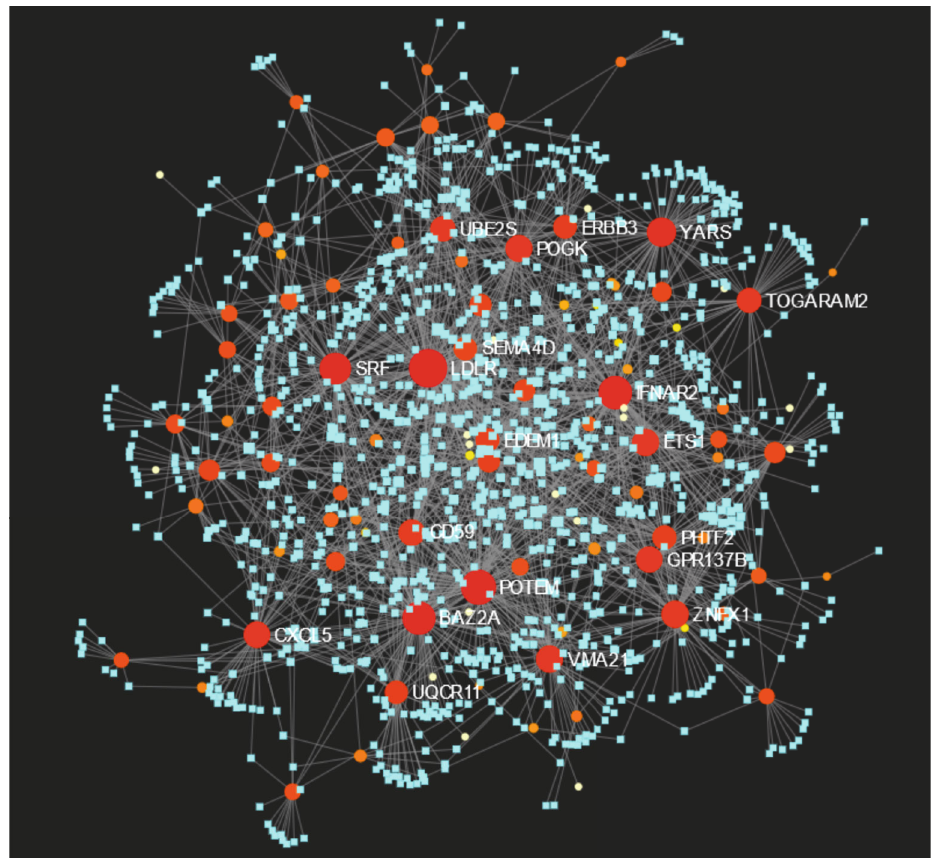
Figure 4: Target gene-miRNA regulatory network. Red and orange nodes stand for di ff erentially expressed genes; blue diamonds stand for